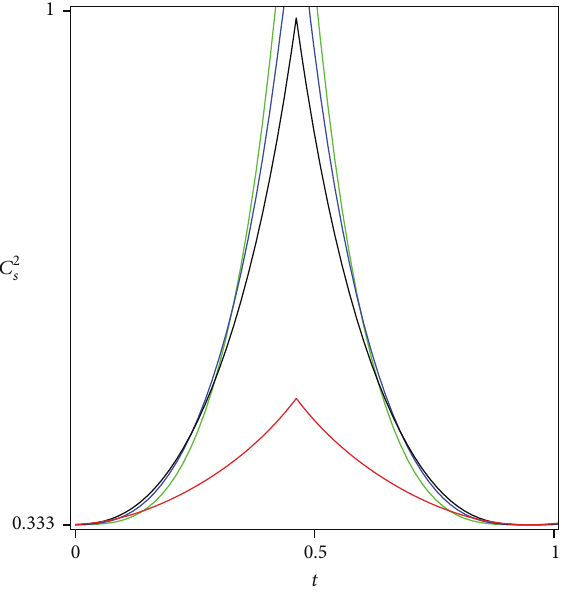
Figure 17: Squared sound speed for 𝐵 = 3 , 𝐶 3 = 1 , 𝑛 = 3 , and 𝐴 = 1/3 . 𝛼 = 1 (green line), 𝛼 = 0.7 (blue line), 𝛼 = 0.5 (black line), 𝛼 = 0.1 (red